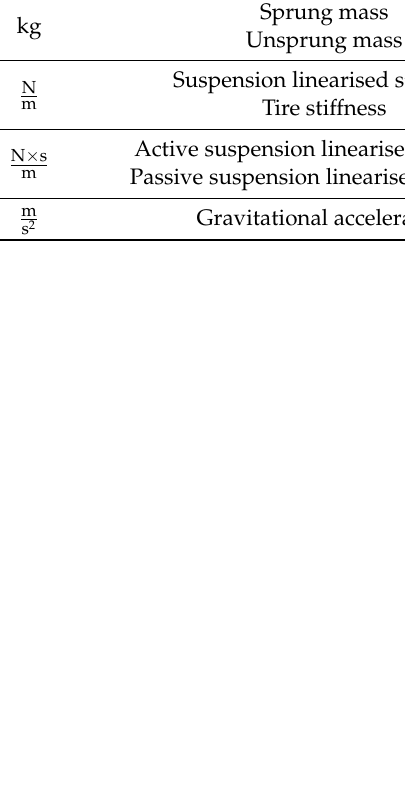
Figure 2. Model of the active suspension